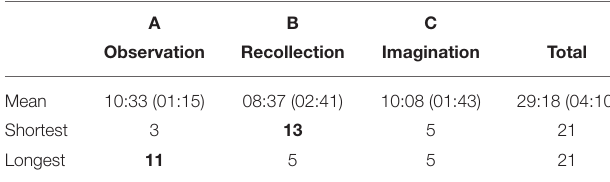
TABLE 4 | Statistics on time spent drawing for each